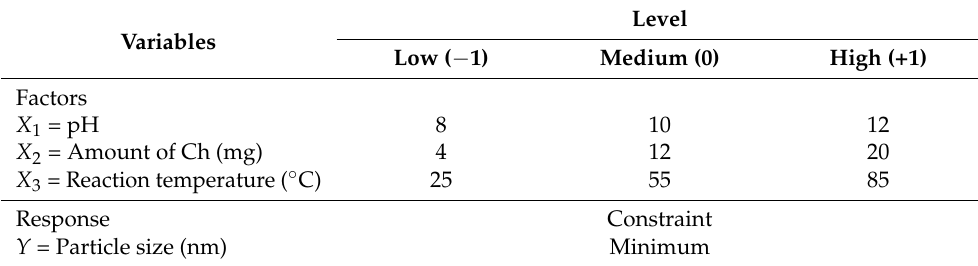
Table 1. Variables used in Box–Behnken